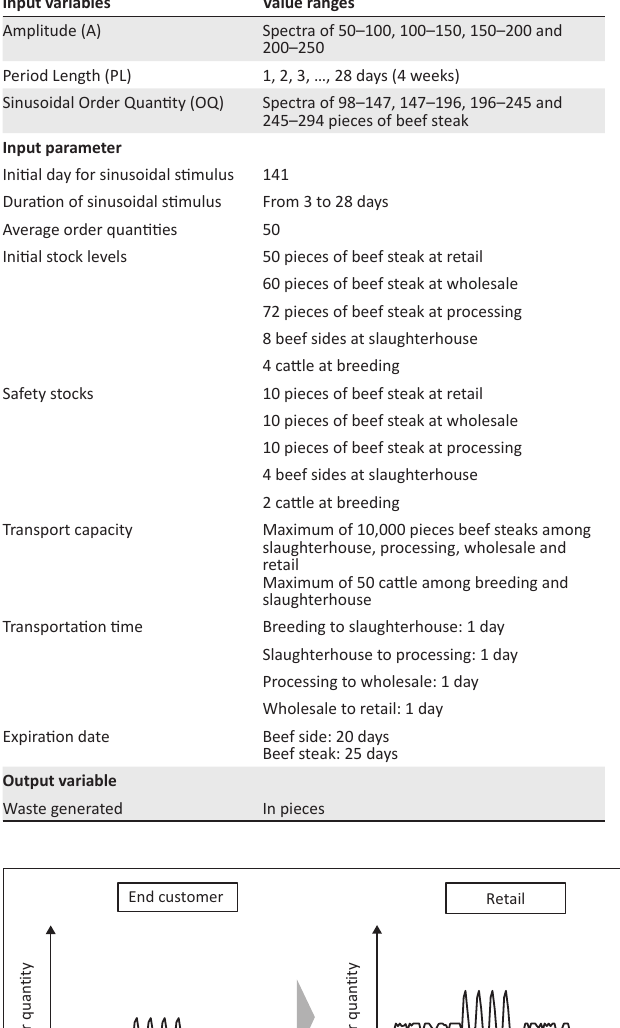
TABLE 3: Input variables and parameter for modelling and simulation.